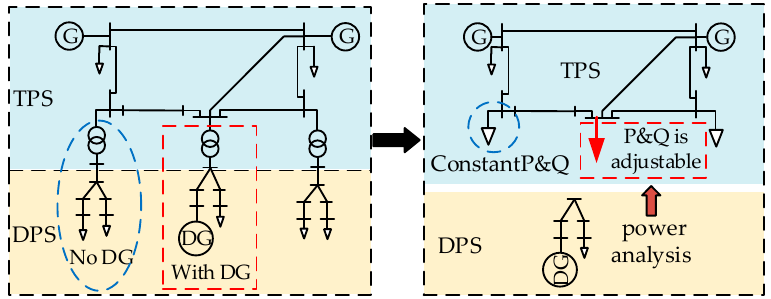
Figure 2. Diagram of transmission power system (TPS) analysis considering reactive power regulation of distribution power system (DPS).